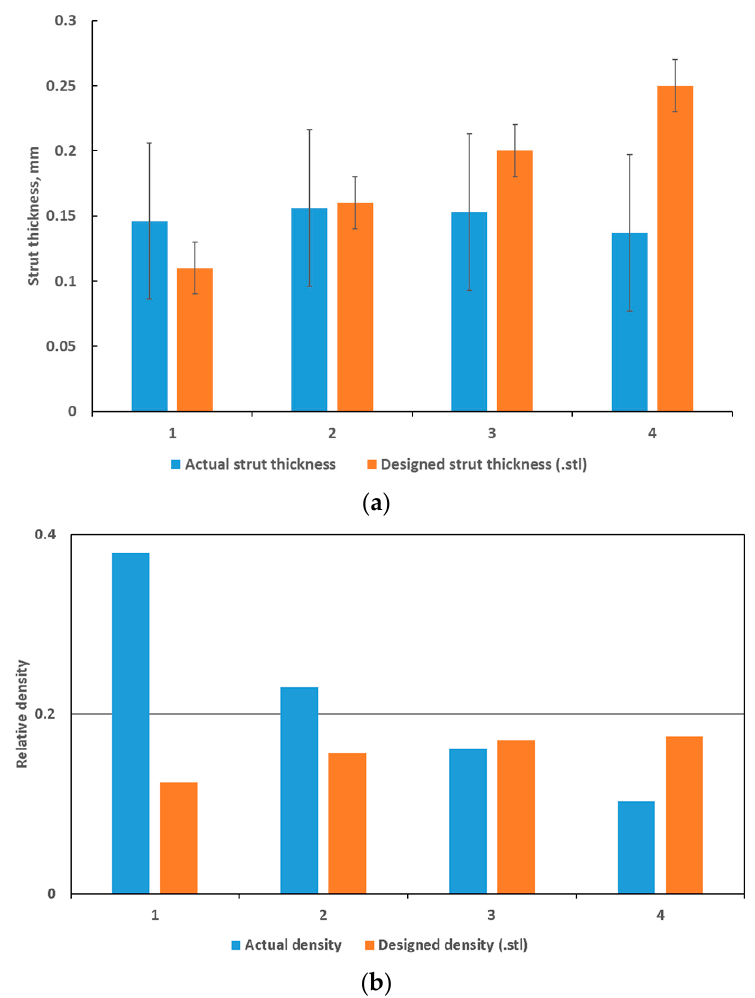
Figure 3. Dimensional assessment of ( a ) actual versus designed strut thickness and ( b ) actual versus designed total density compared to the designed values. Maximum and minimum values are shown as an error margin but indicates the variability within a single strut, as measured manually from 3-D model .stl data and microCT data.